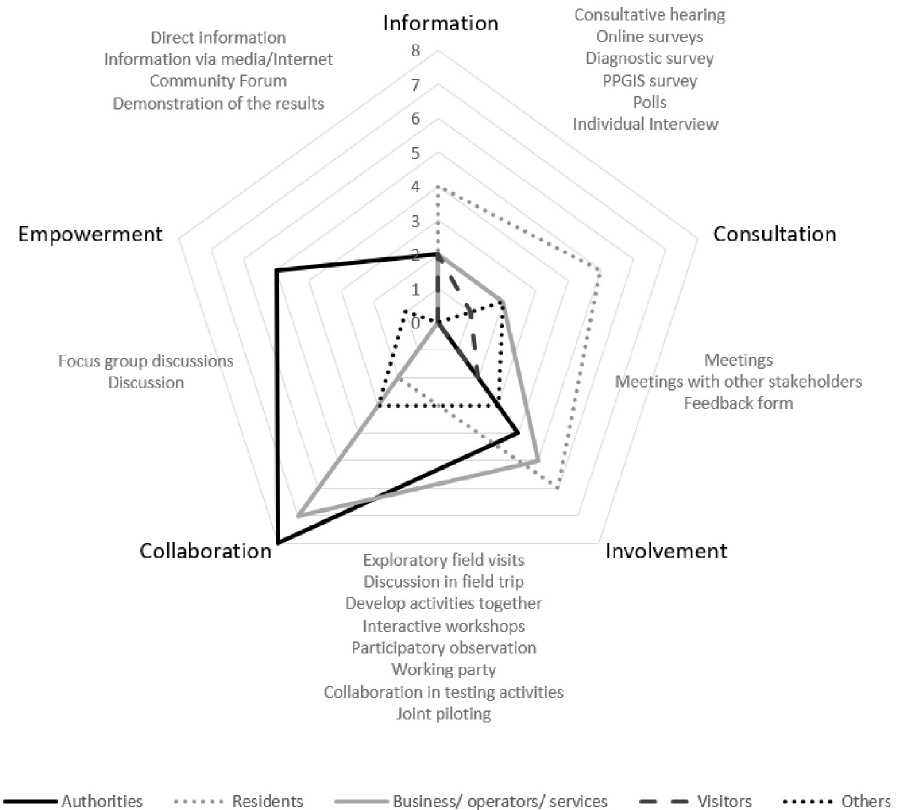
Fig 9. Identification of stakeholder engagement methods/techniques with regard to the specifics of stakeholder groups and the level of their involvement in the process of improving the mobility problem of a given touristic area. Source: Own